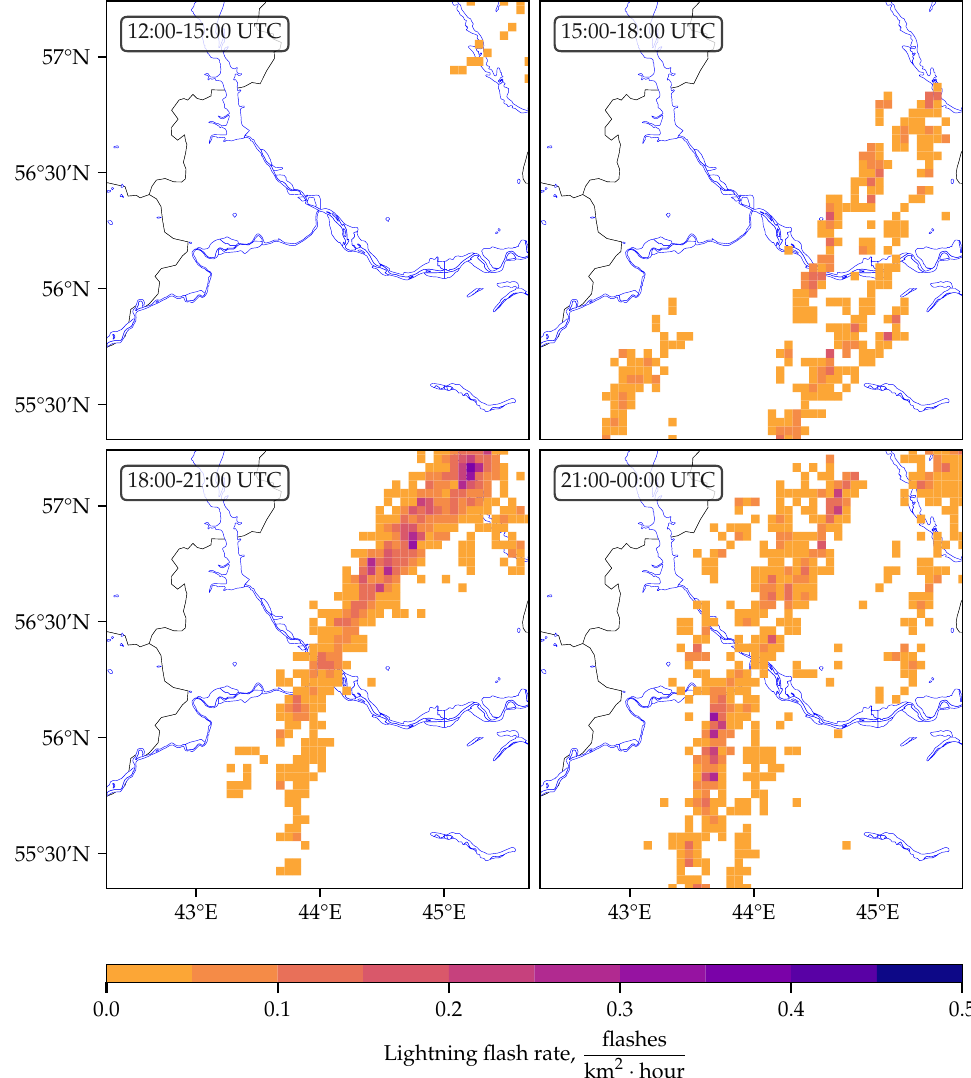
Figure 7. Lightning flash rate calculated for every cell at 3 h intervals. Time domain of the panels